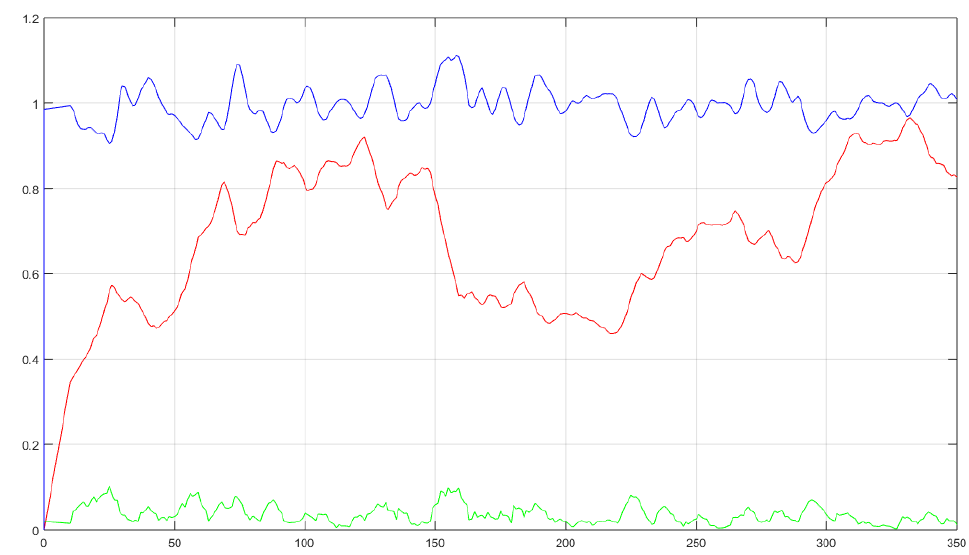
Figure 9. The normalised 5-day rolling average of the opening BTS–USD prices from 17-12-2020 to 30-11-2021 (red line), the corresponding Volatility of the signal (green line), and the Lévy index (blue line) computed using a moving window with a period of